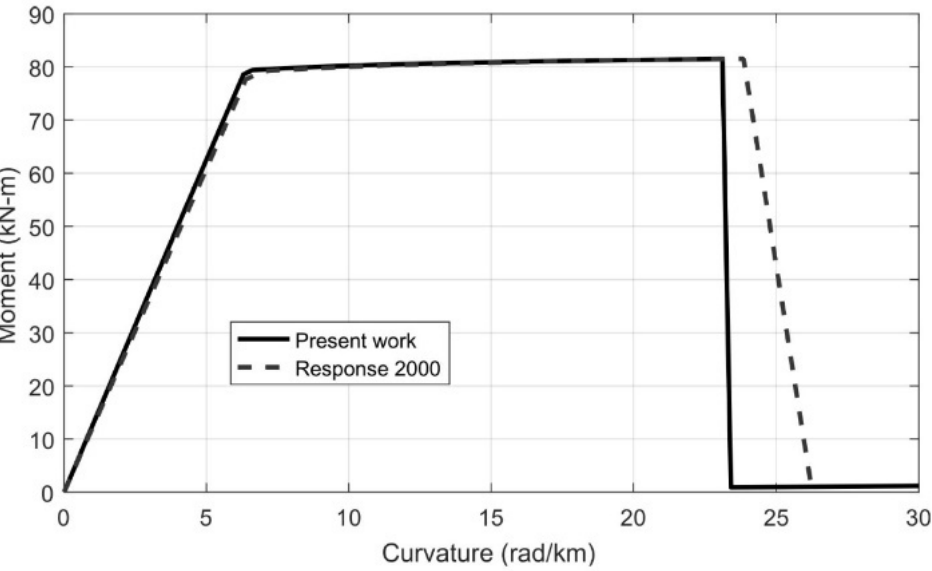
Figure 9. Moment-curvature of rectangular cross section.